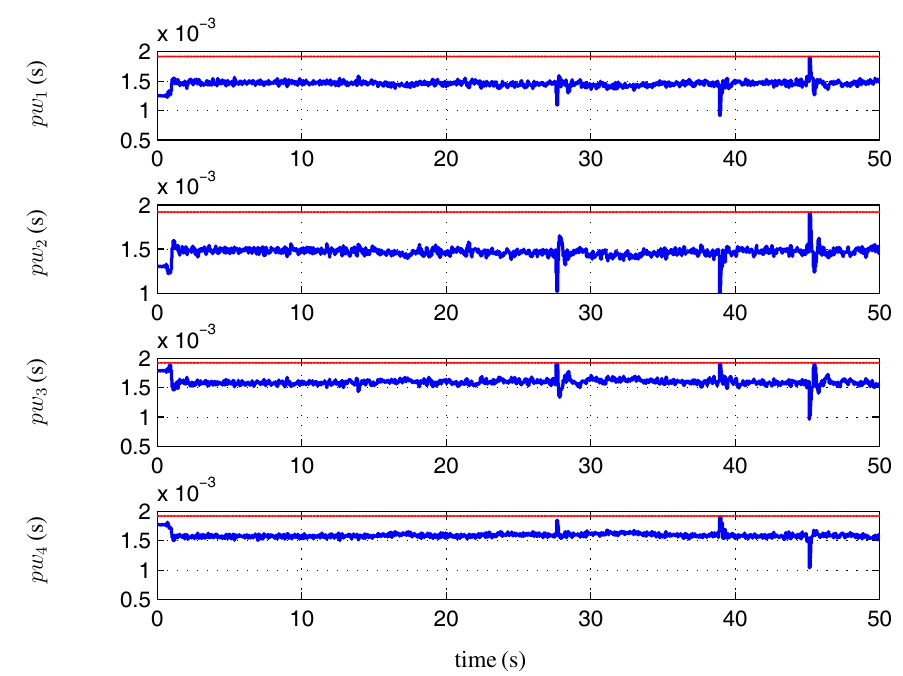
Figure 17. Control law of Corollary 2: the pulse width of the four motors’ control signals. The red dashed lines define the bounds of the pulse